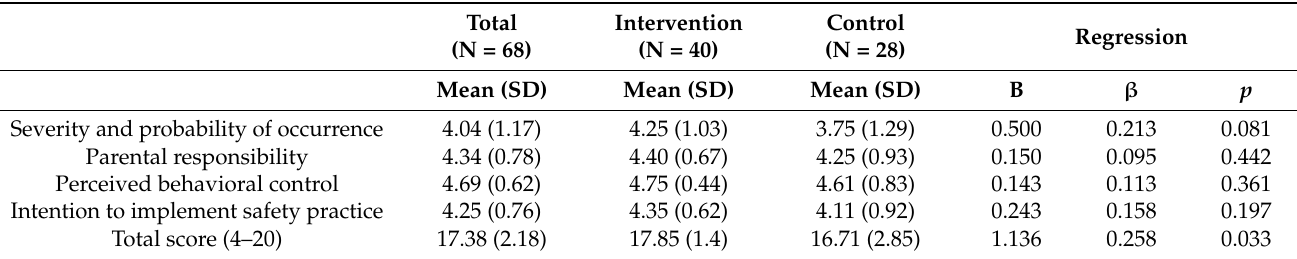
Table 2. Mothers’ perceptions of injury prevention.